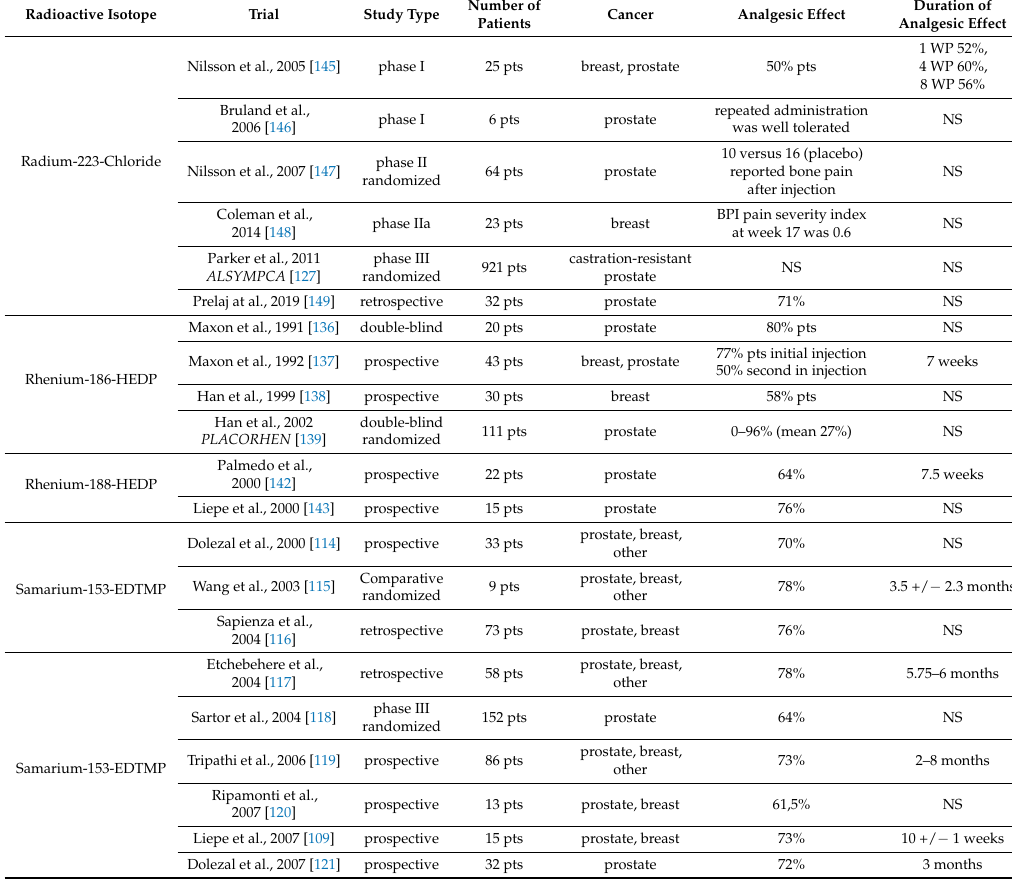
Table 5. Radioactive isotopes used for the treatment of painful bone